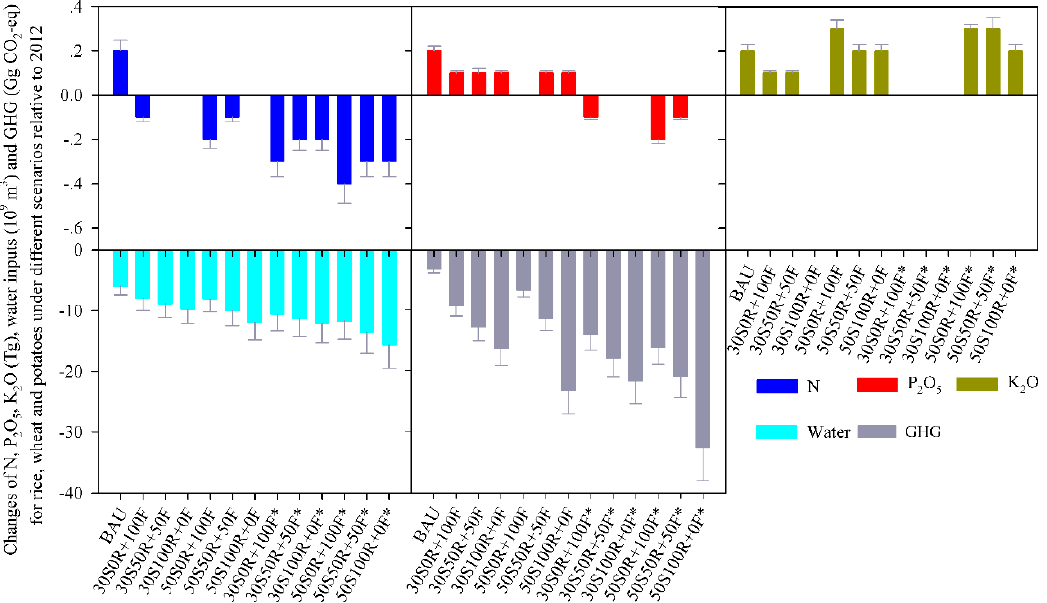
Figure 4. Chemical N-, P 2 O 5 - and K 2 O-feitilizer inputs, irrigation-water consumptions and total GHG for rice, wheat, conventionally grown potatoes (Potato-Con), and optimally grown potatoes (Potato-Opt) under different scenarios, compared with 2012.